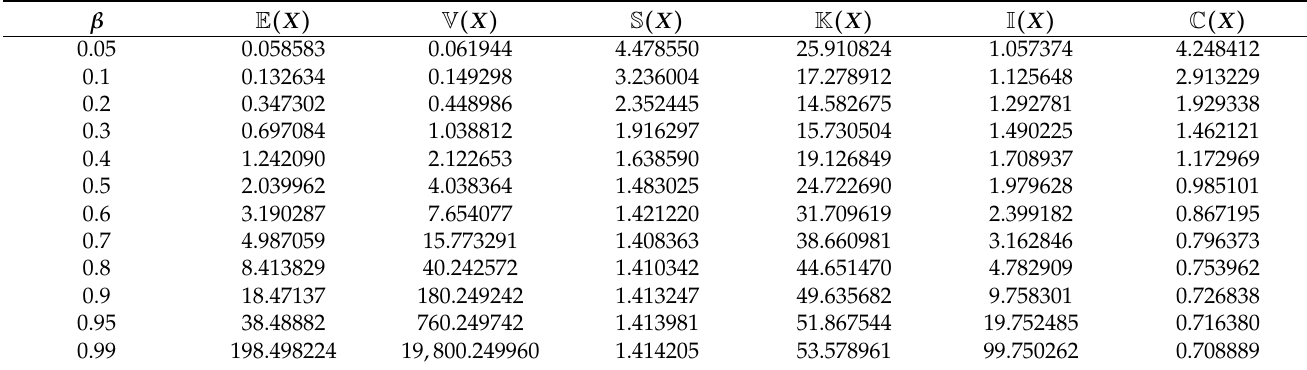
Table 1 lists some numerical results of some descriptive statistics (DS) for the NDsLE model for different values of the parameter β . Table 1. Some DS for the NDsLE model under various values of β